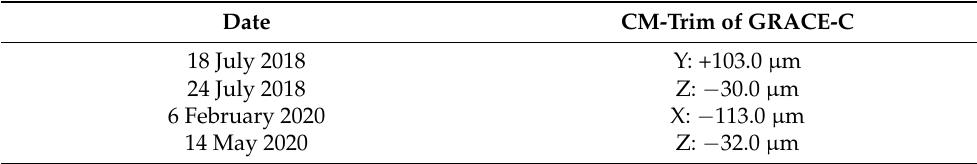
Table 4. CM-trim events of GRACE-C.